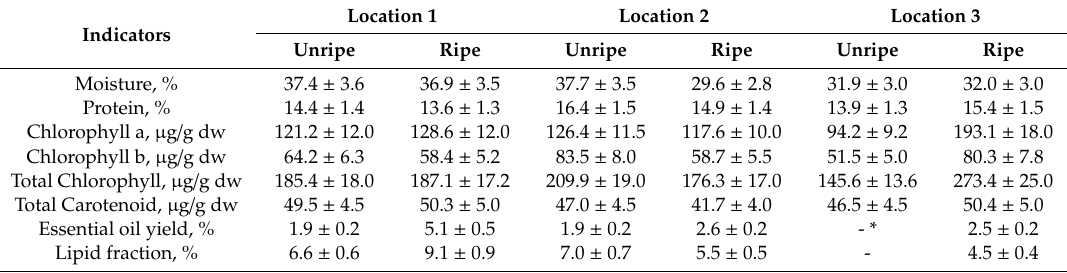
Table 1. Proximate composition of J. excelsa unripe and ripe galbuli from the three collection sites in Bulgaria (mean ±